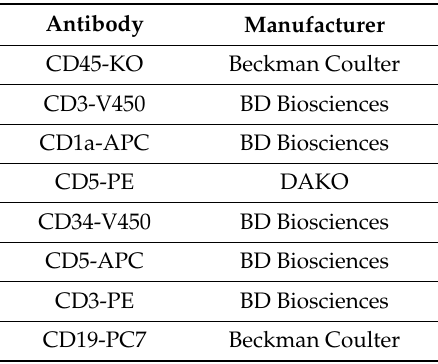
Table A2. The list of fluorescently-labeled antibodies used in this study.